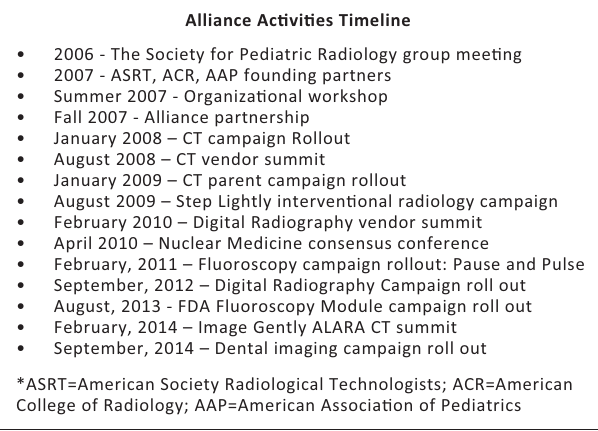
FIGURE 1: The timeline of major activities by the Alliance for Radiation Safety in Pediatric Imaging from inception to present.